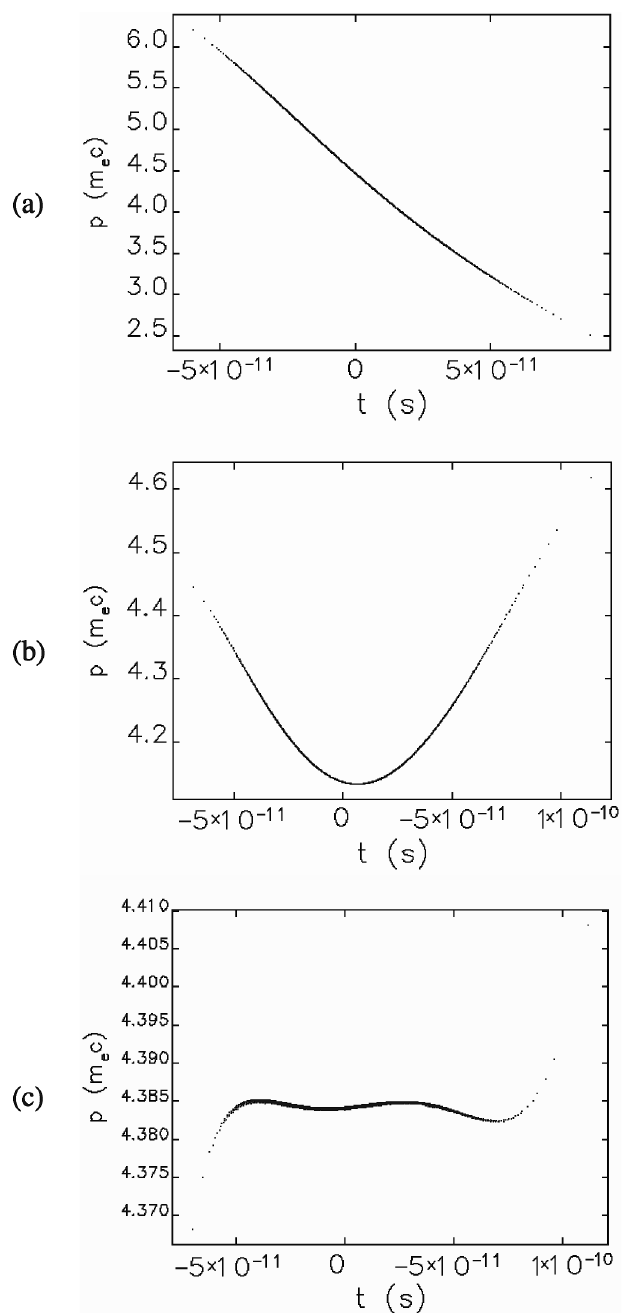
FIG. 14. Longitudinal phase space in ‘‘welder’’ configuration, (a) after gun, (b) after 1st-harmonic linearizer, and (c) after 3rd- harmonic linearizer cavity, and (c) after the 3rd-harmonic linearizer cavity. The beam energy is lower than above, and the energy spread is larger, because the energy filter is not removing the ‘‘wings.’’ Thus, a different minima for the energy spread is found. The transverse quality is also worse, at about 4 (cid:9) 10 (cid:8) 3 (cid:1) m . On the other hand, the entire beam current of 0.5 mA is transmitted, for a final beam power of about 700 W.